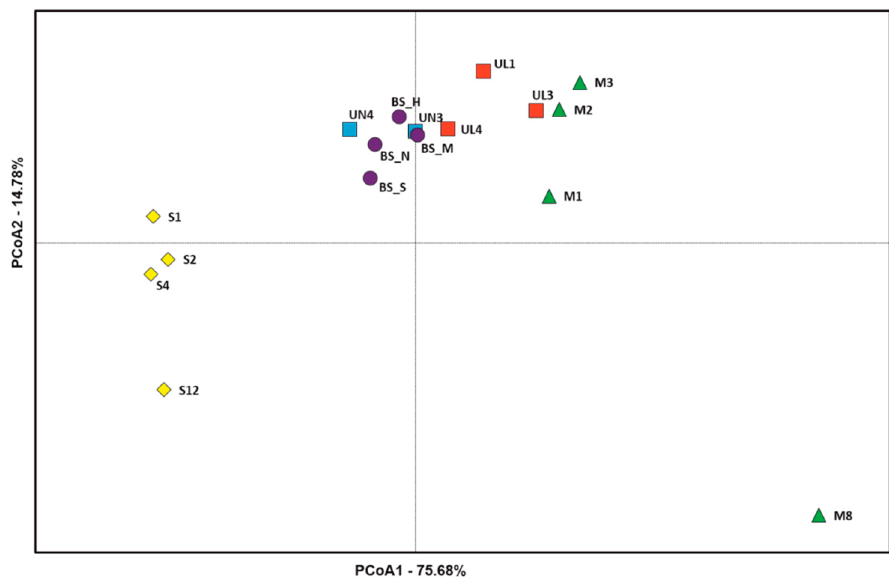
Figure 3. Principal coordinates analysis (PCoA) based on Nei genetic distance at nSSR loci showing genetic relationships between groups of samples defined at the mixed pine population from Bł˛edne Skały (BS) and reference populations of the four pine species (population acronyms as in Table 1). Structure analysis at nSSR loci indicated the presence of five genetically distinct groups corresponding approximately to the four reference species and one sample group from BS (Figure 4,